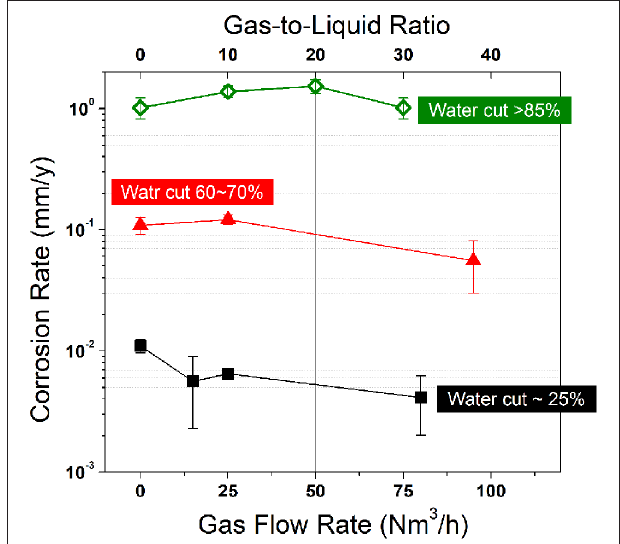
FIGURE 5 | The measured corrosion rate as a function of gas flow rate (or Gas-to-liquid ratio) at different water cuts obtained from the multiphase flow loop test at 0.3 MPa in field condition of Shengli oilfield. The crude oil was heavy oil with a density of 0.92 g/cm 3 at 20 ◦ C and a viscosity of 135.3 mPas at the operation temperature of 60 ◦ C. The fraction of CO 2 in gas phase was around 50 vol.%. For the present field test, the liquid flow rate was 4.5 m 3 /h. The input fluid was controlled by pumps and the water cut was experimentally estimated by on-site sampling of the oil-water